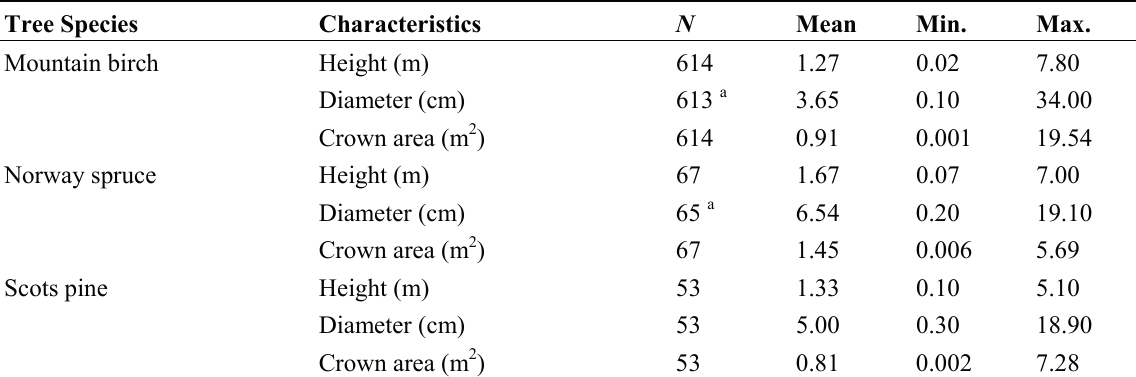
Table 1. Summary of field measurements of